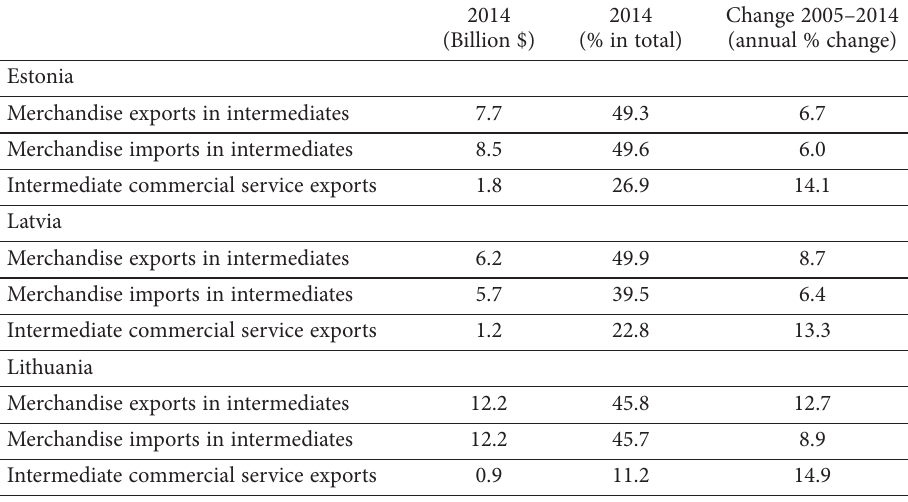
Table 2. Evolution of trade in intermediate merchandises and commercial services in the Baltic States,